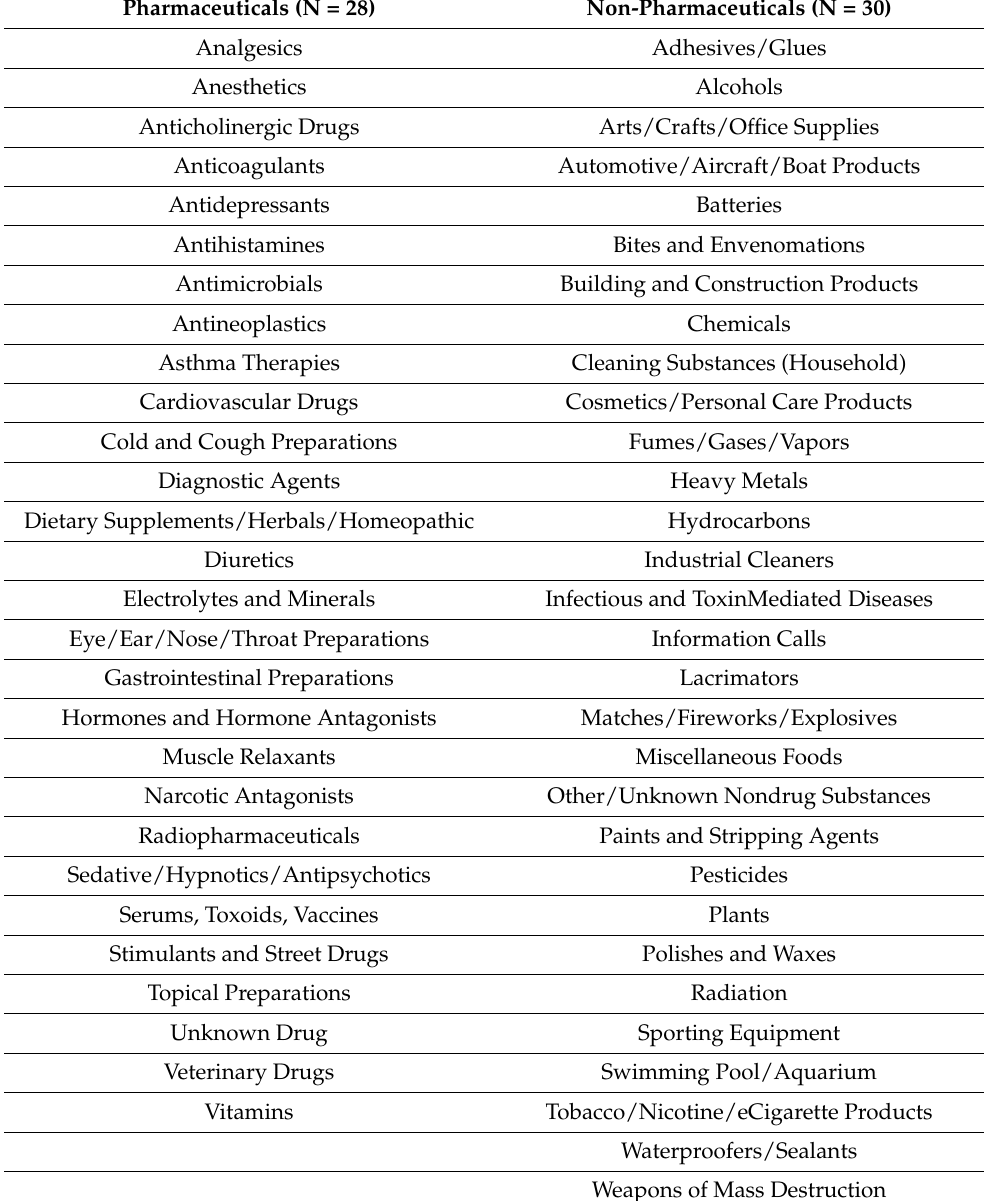
Major Generic Substance Categories of Exposures in Pharmaceuticals and Non- Pharmaceuticals as listed in 2019 NPDS Annual